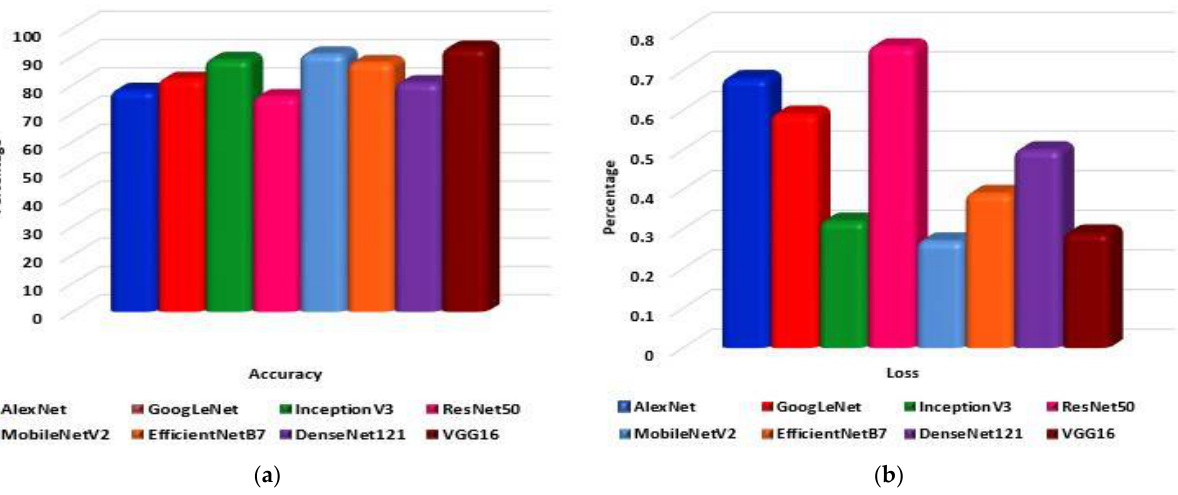
Figure 10. The eight pre-trained models: ( a ) Accuracy and ( b ) Loss comparative graph to classify lung disease.